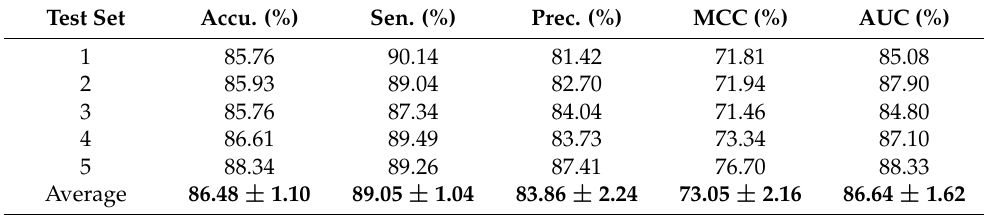
Table 7. Comparison outcomes of SVM model and MSPEDTI on ion channel.